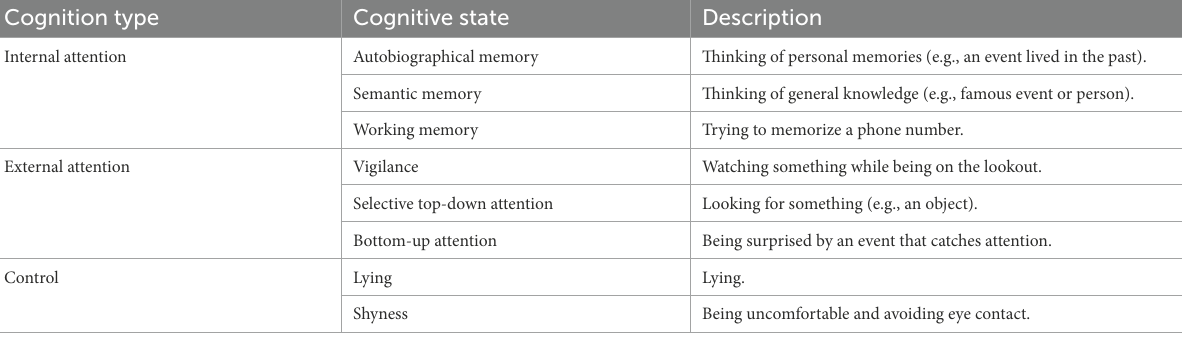
TABLE 1 Mental states categories and corresponding descriptive labels provided to